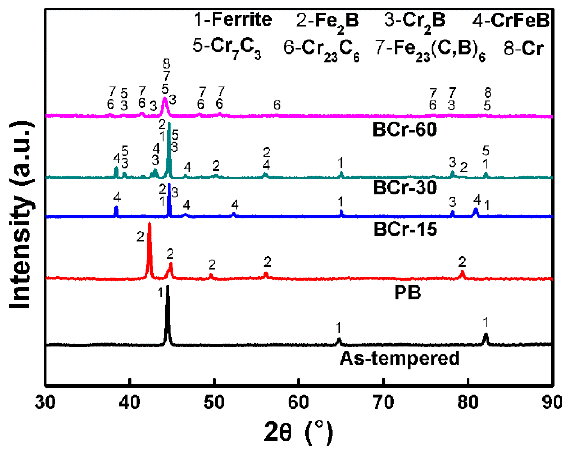
Figure 1. XRD patterns revealing the phases of various